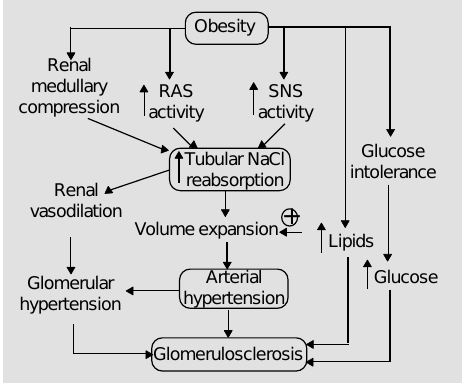
Figure 8 - Summary of mechan- isms by which obesity may cause hypertension and glomer- ulosclerosis by activation of the renin-angiotensin (RAS) and sym- pathetic nervous systems (SNS), metabolic abnormalities, and compression of the renal me-